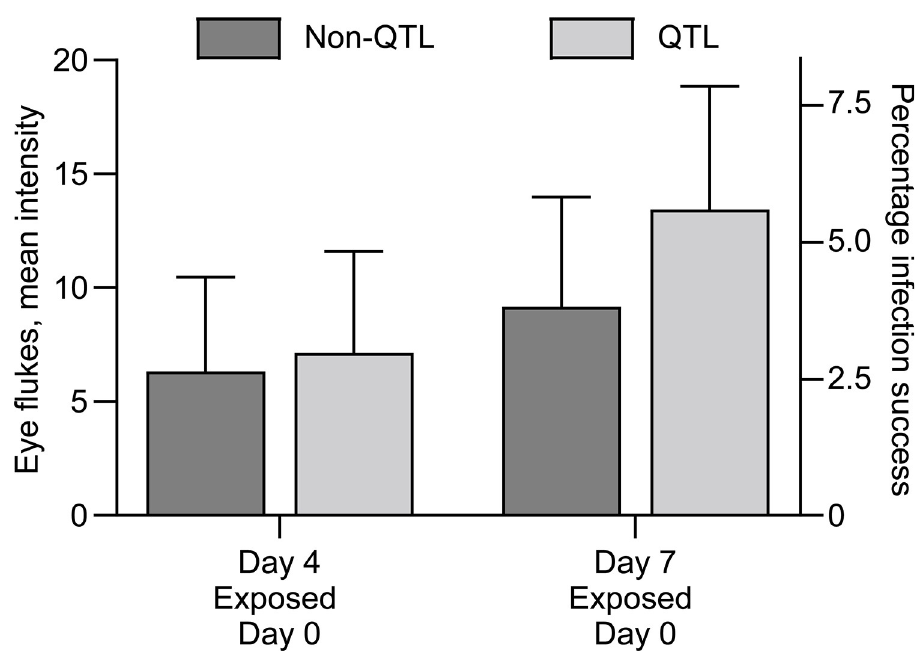
Fig 2. Eye fluke mean intensity and infection success in QTL and non-QTL fish on 4 and 7 days post exposure.